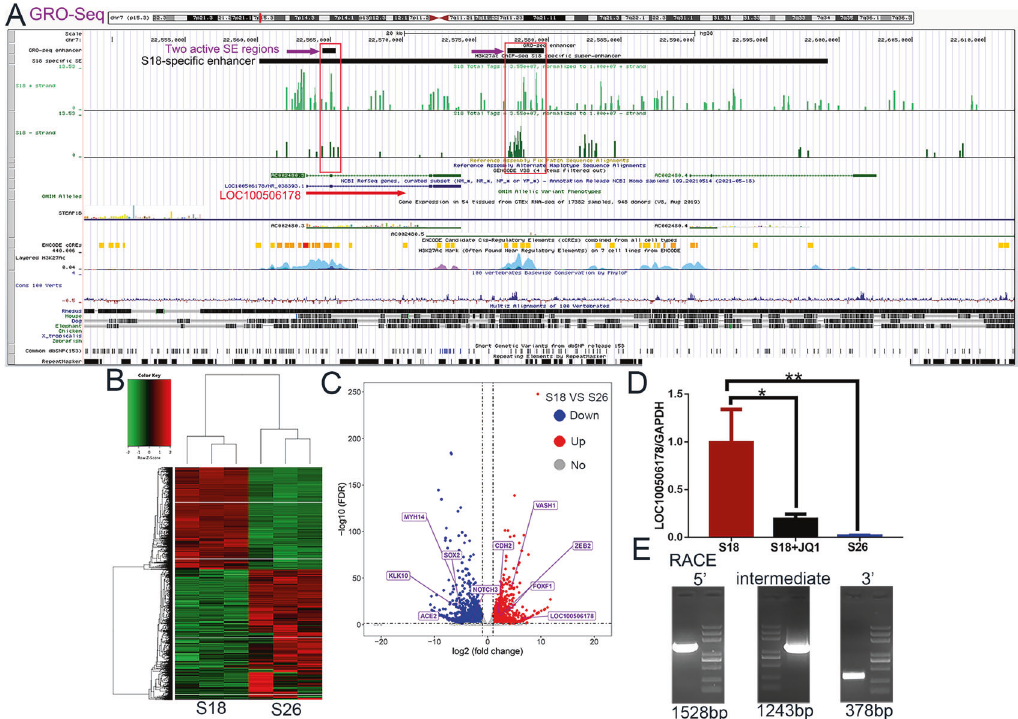
Fig. 2 A speci fi c SE transcribed into seRNA LOC100506178 and its sequences. A The locations of the S18-speci fi c SE, seRNA LOC100506178 and active SE regions were visualized using UCSC, and the red squares represented the transcription-active SE regions that transcribed into seRNA LOC100506178 (NR_038393). B Heatmap showed the normalized expression of signi fi cantly deregulated genes between S18 and S26 cells ( n = 3). C Log2 (fold change) versus log (FDR) of the differential genes expression between S18 and S26 cells. D The transcription of the seRNA LOC100506178 in S18, JQ1-treated S18, and S26 cells was detected with RT-qPCR. E Cloning products of seRNA LOC100506178 were identi fi ed using RACE (left to right: 5', intermediate fragment, and 3'). ** P < 0.01; * P < 0.05.